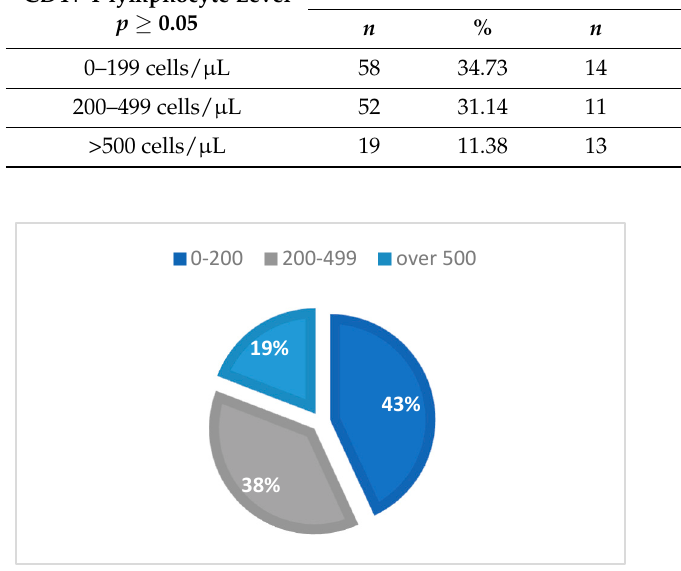
Figure 3. Distribution of cases by CD4+ T-lymphocyte level (cells/ μ L).